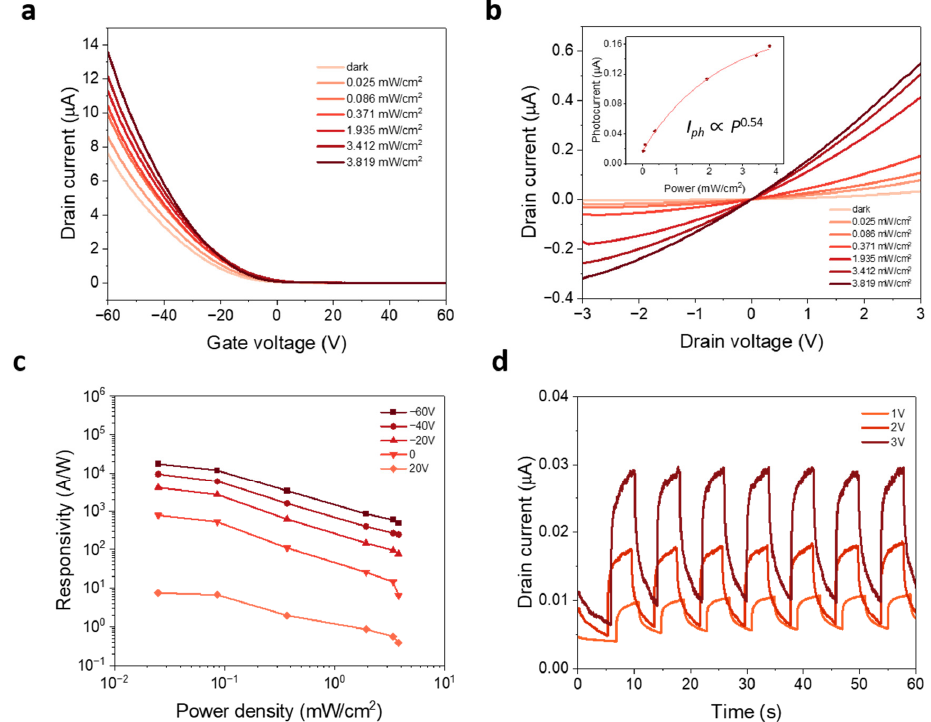
Figure 4. ( a ) Transfer characteristics of transfer-free monolayer WSe 2 -based photodetectors under different 532 nm laser power densities. ( b ) I ds -V ds output curves under different light illuminations. (Insert shows the device photocurrent as a function of P). ( c ) Dependence of the responsivity on the power density with different values of back-gate voltage. ( d ) Time-dependent dynamic photore- sponse at different bias voltage under 532 nm incident light illumination with a power intensity of 3.05 mW/cm 2